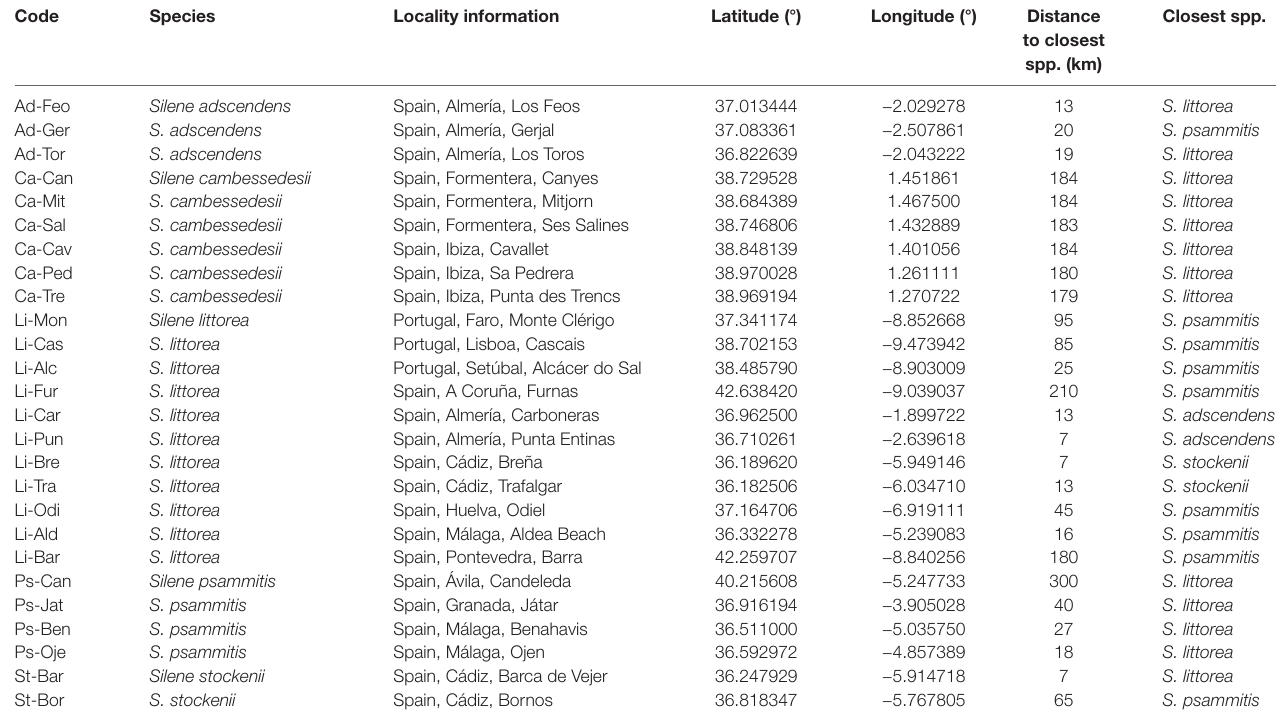
TaBle 1 | Sample localities (populations of each species are ordered by name) and distance to the closest